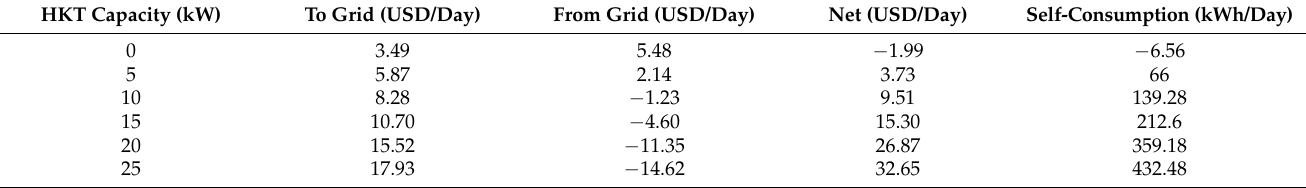
Table 6. Daily energy cost and self-consumption for different HKT capacities (PV = 15 kWp).